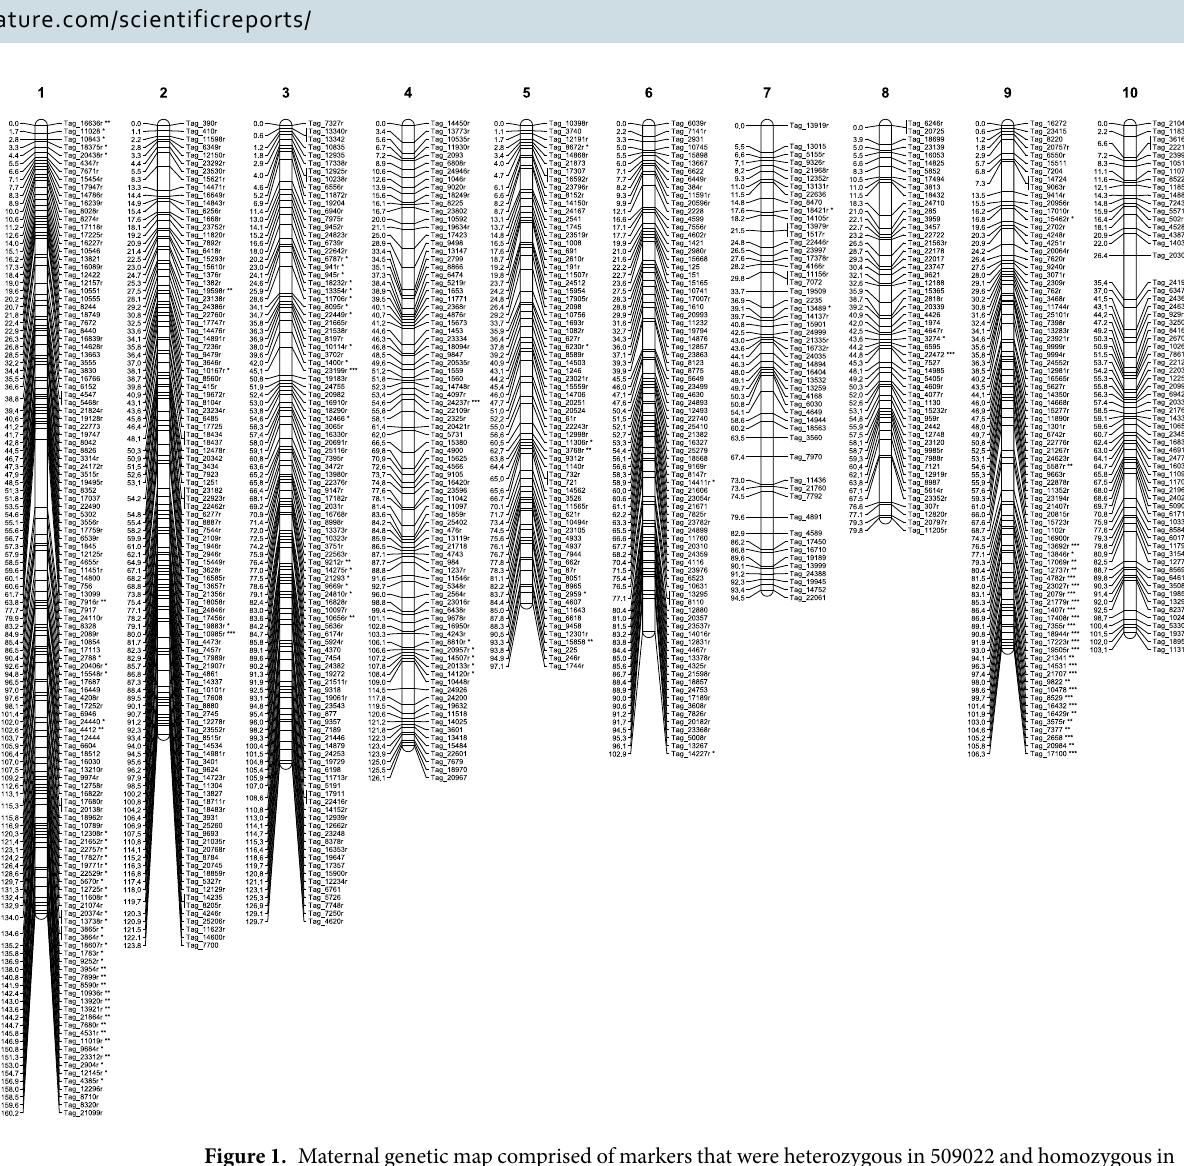
one marker per set of cosegregating markers is shown. Markers that deviated significantly from the Mendelian segregation ratio of 1:1 are indicated with * (deviation at the 5% level), ** (1% level) or *** (0.1% level) next to the marker